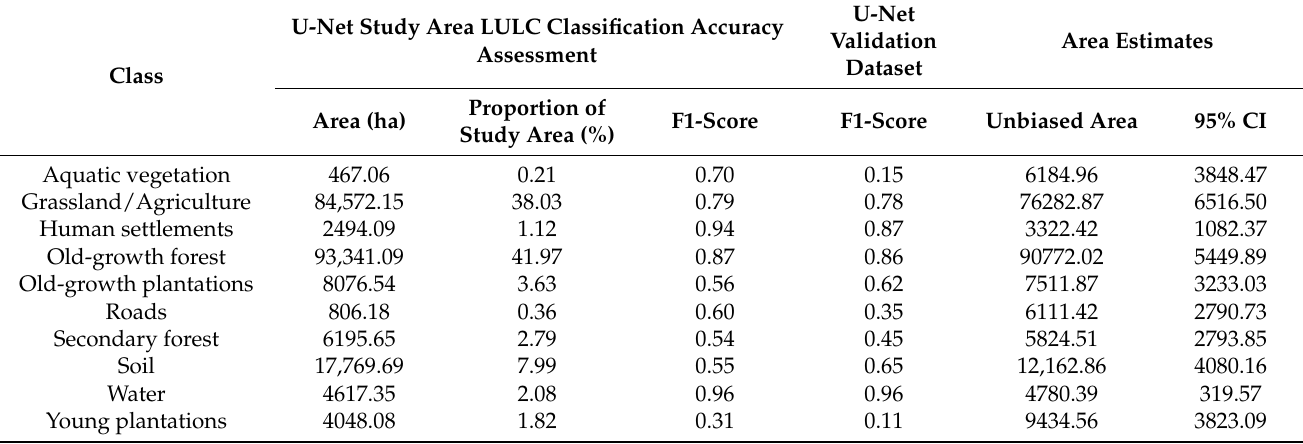
Table 2. Area estimates and F1-score obtained for the U-net ensemble classification, as well as the unbiased area and 95% confidence intervals for the area occupied by each class. CI: confidence